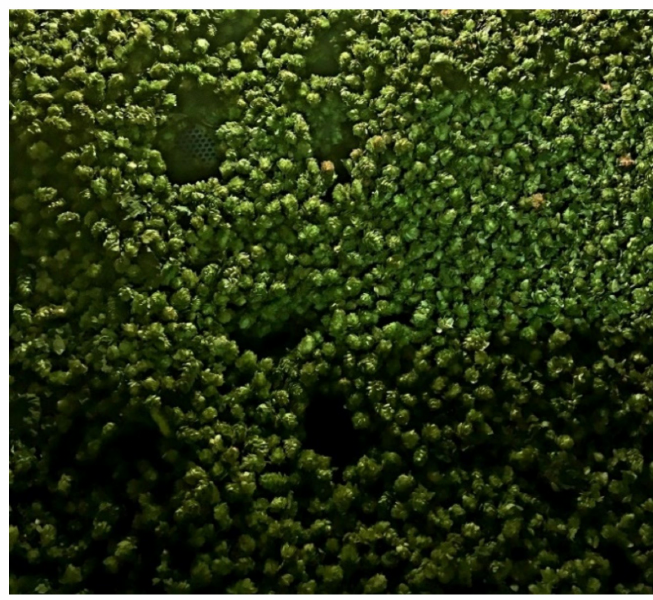
Figure 7. Air channel formation in a 15 kg / m 2 bulk of